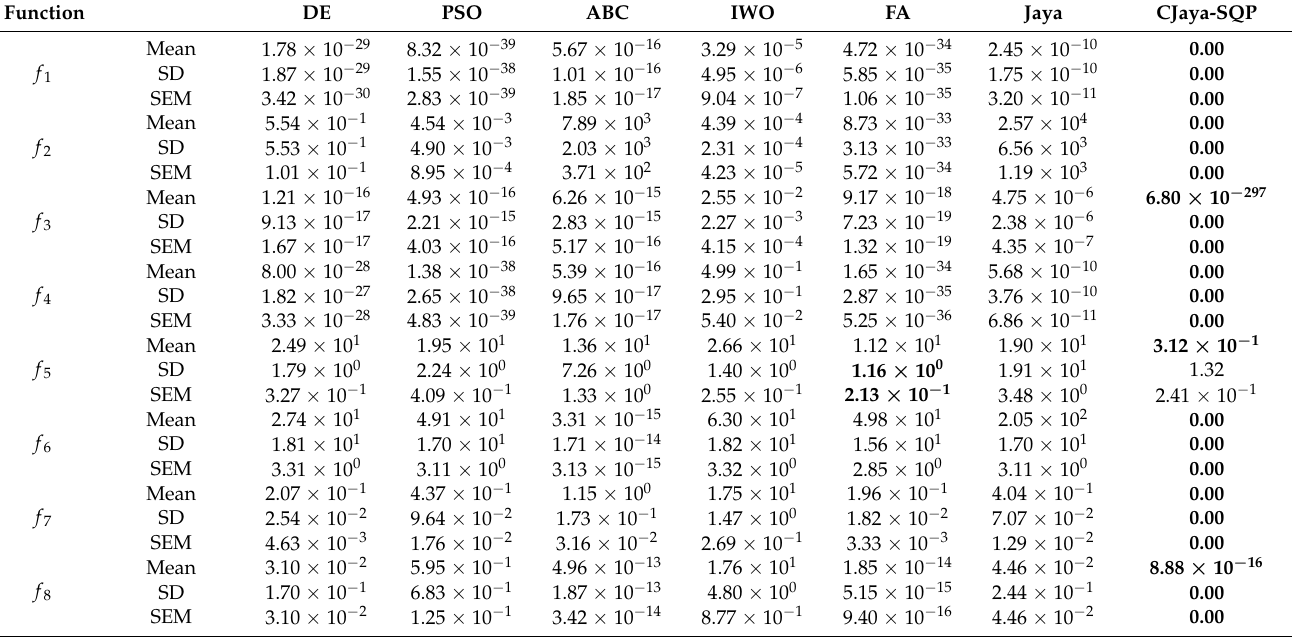
Table 5. Statistical results obtained by comparative algorithms for 30-dimensional functions over 30 runs with 80,000 function